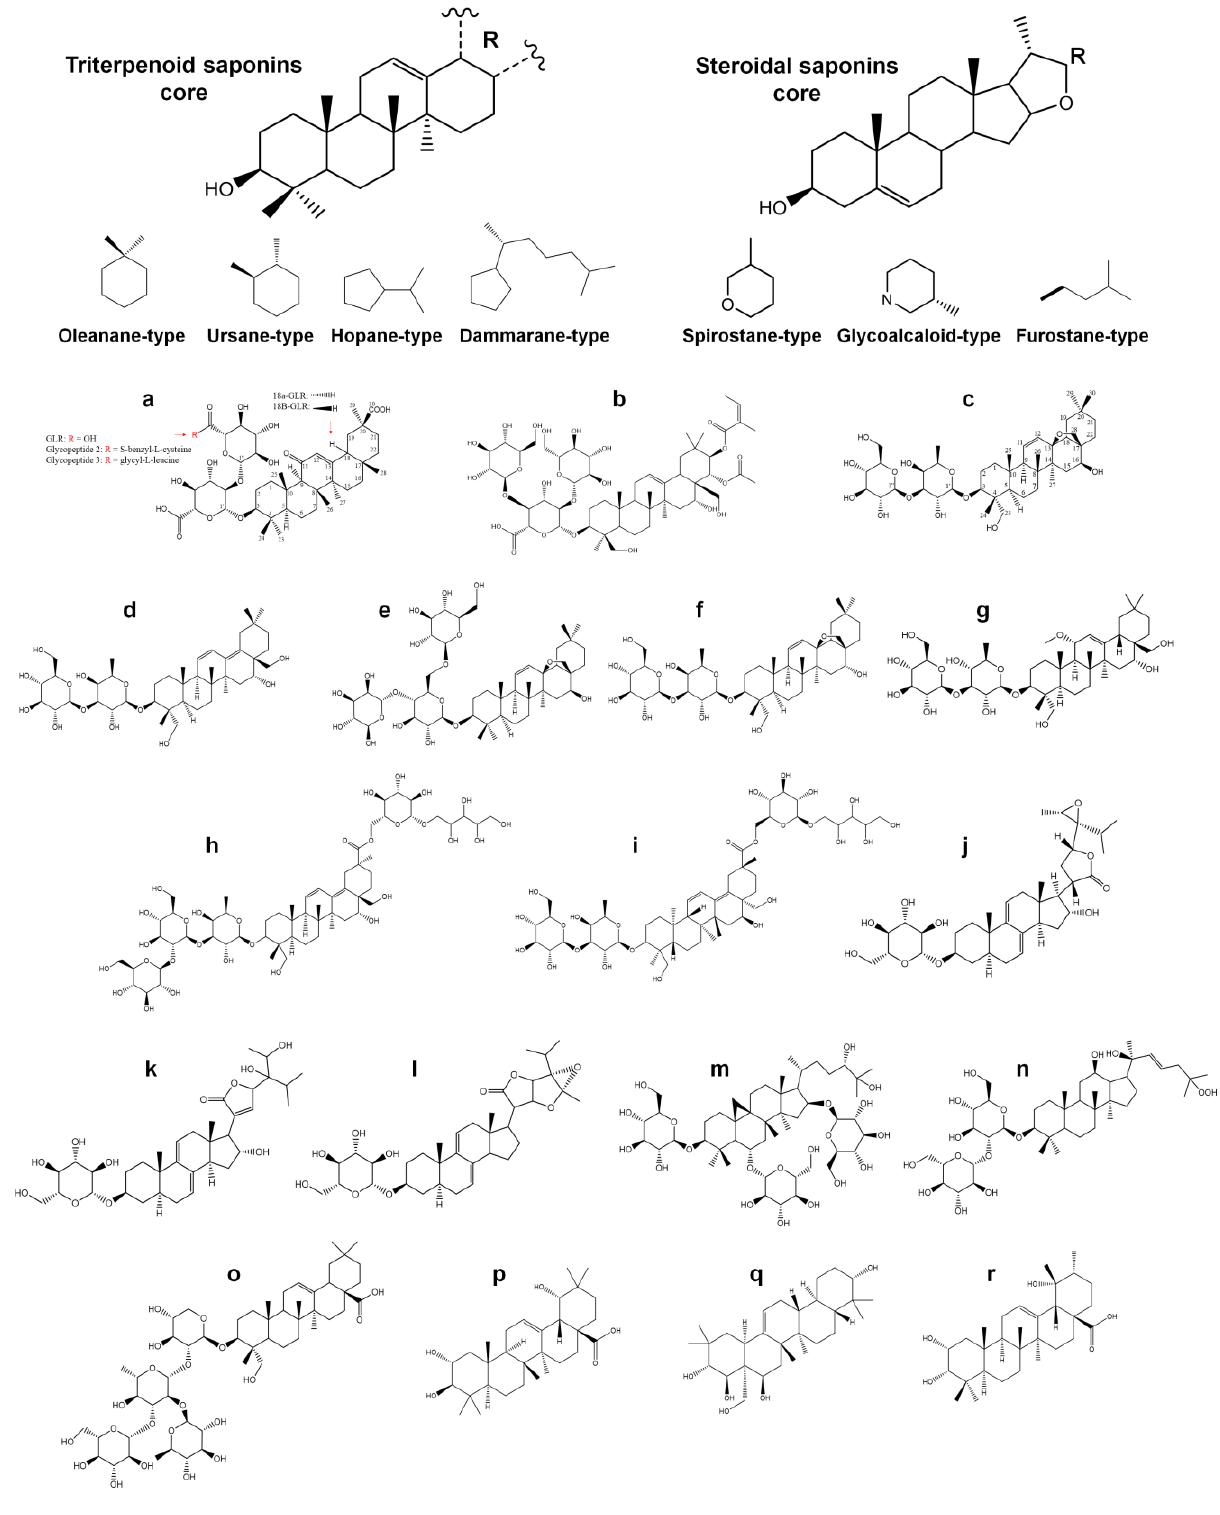
Figure 1. Chemical structure diversity in saponin aglycones and main saponins with anti-SARS-CoV-2 activity. ( a ) Glycyrrhizin; ( b ) β -Escin; ( c ) Saikosaponin A; ( d ) Saikosaponin B2; ( e ) Saikosaponin C; ( f ) Saikosaponin D; ( g ) Saikosaponin B4; ( h ) Saikosaponin U; ( i ) Saikosaponin V; ( j ) Vernonioside A2; ( k ) Vernonioside A4; ( l ) Vernonioside D2; ( m ) XGG-pentahydroxycycloartane; ( n ) Ginsenoside Rg12; ( o ) TPG1; ( p ) arjunic acid; ( q ) Theasapogenil B; and ( r ) euscaphic acid.